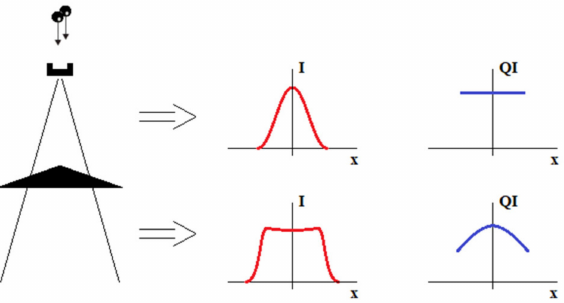
Figure 6. High energy X-ray (6 MV and 15 MV) intensity (I) and radiation quality (QI) off-axis character- istics at selected stages of therapeutic beam generation in a classic medical accelerator—simplification.